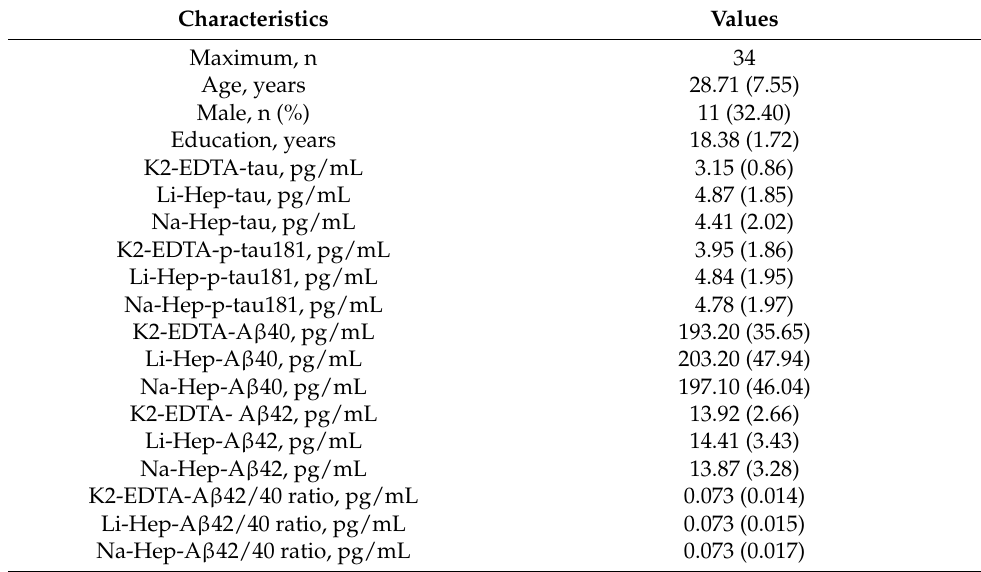
Table 1. Demographic characteristics and AD biomarkers levels of the